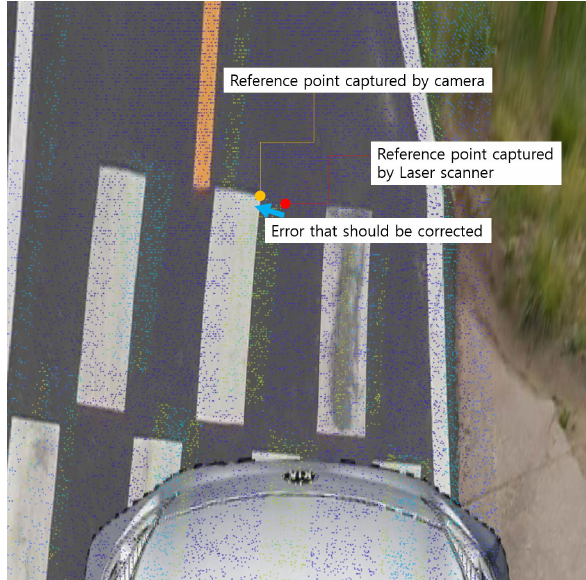
Figure 5. Error in obtaining MMS location information through